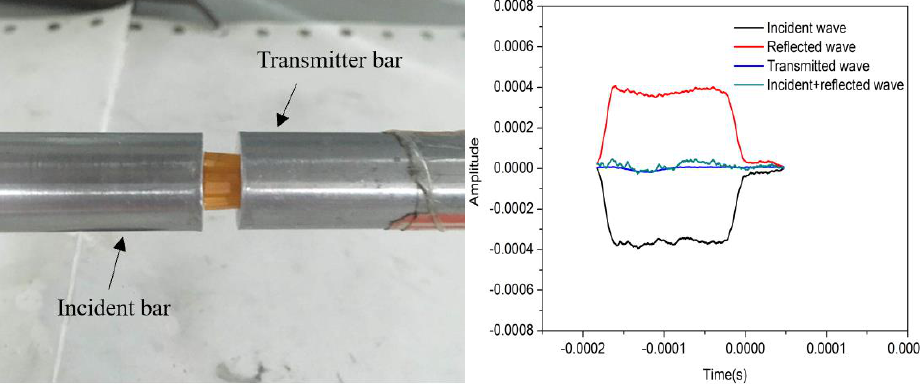
Polymers 2021 , 13 , x FOR PEER REVIEW Figure 4. Schematic diagram of split Hopkinson pressure bar. Figure 4. Schematic diagram of split Hopkinson pressure bar.